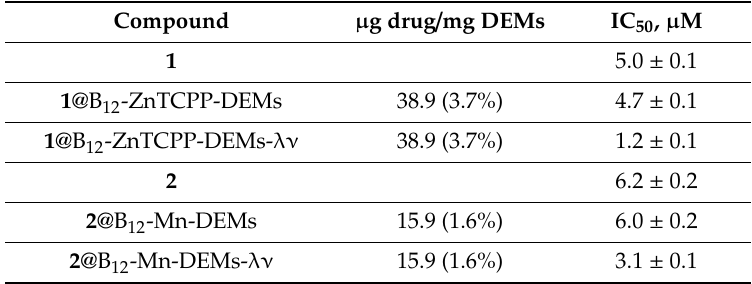
Table 2. Loading degrees of rhenium complexes 1 and 2 in % wt into DEMs and in vitro cytotoxicity (HCT-116 cells, IC 50 , µ M) of complexes and when administered free, in DEMs in the dark (@B 12 - X -DEMs) and in DEMs following photoactivation of their surface (@B 12 - X -DEMs- λν ).